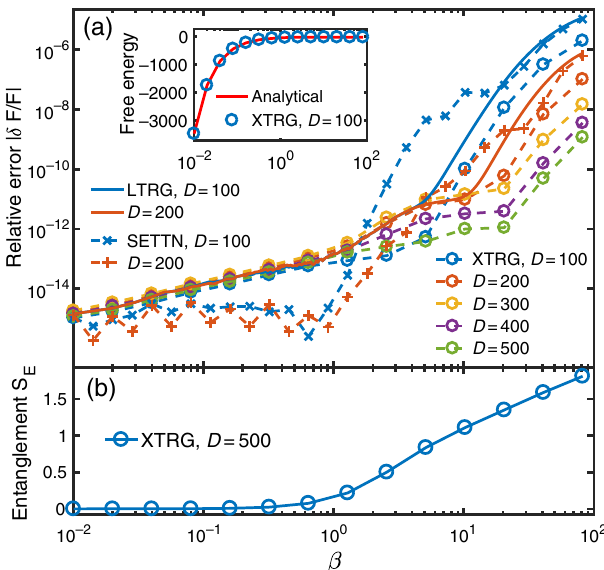
FIG. 4. (a) Relative errors of free energy of an L ¼ 18 spin- 1 = 2 Heisenberg chain (PBC), calculated by TTN algorithms including LTRG, XTRG, and SETTN relative to ED, with SU(2) symmetry implemented, throughout. Data for different methods share the same color for the same D (cid:3) . Here, ρ ð τ 0 ¼ 0 . 01 Þ is initialized using SETTN. (b) Bipartite entanglement entropy S E in the middle of the MPO, which increases monotonically. The time costs of the LTRG calculations are 8 (10) times as long as SETTN and 180 (113) times those of XTRG, in D (cid:3) ¼ 100 (200) calculations, respectively.